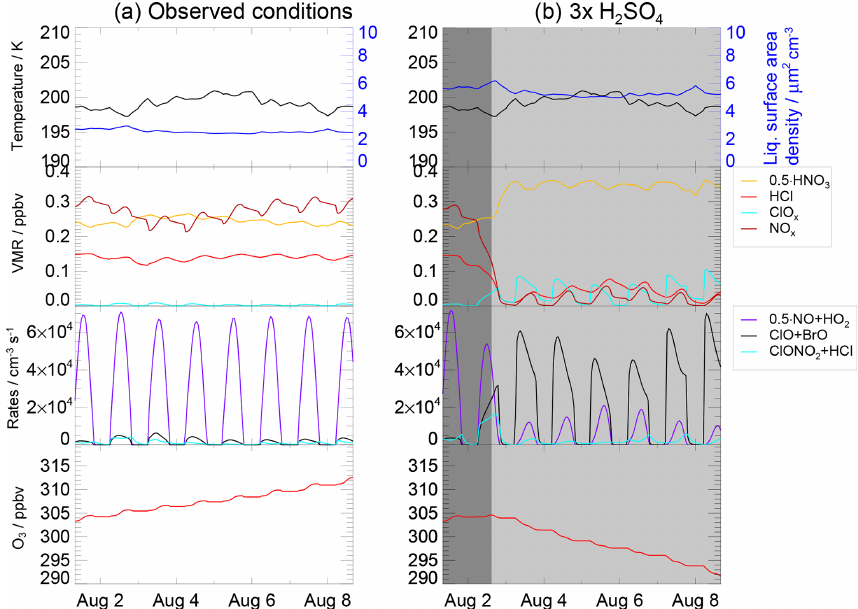
Figure 10. Panel (a) presents the temperature, liquid surface area density, ozone mixing ratio, reaction rates of Reaction (R1) (ClONO 2 + HCl, cyan), Reaction (R17) (ClO + BrO, black) (as an example for ozone loss cycles), Reaction (R6) (NO + HO 2 , violet) which limits ozone formation at low NO x concentrations as well as volume mixing ratios of HCl (red), ClO x (light blue), NO x (black) and HNO 3 (scaled with 0.5) for the “case based on observations” with 10.6ppmv H 2 O and 0.20ppbv H 2 SO 4 . Panel (b) shows the same quantities, but for enhanced sulfate conditions (0.60ppbv H 2 SO 4 ). The x axis marks refer to 00:00 local time (06:00UTC) of that